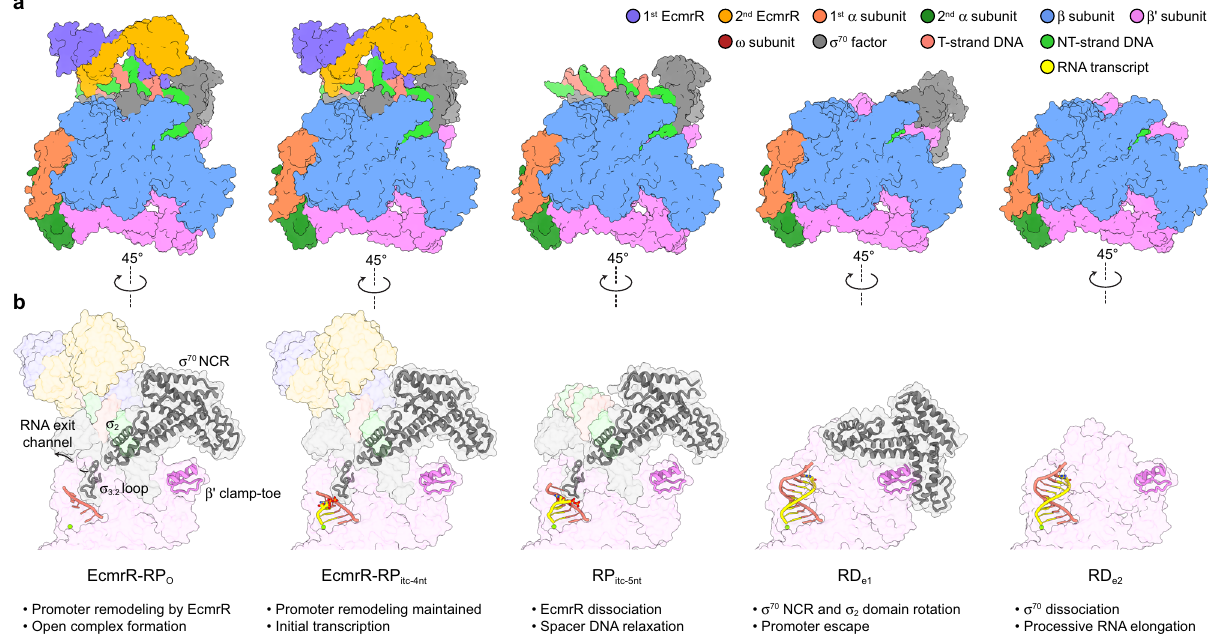
Fig. 7 Structural visualization of EcmrR-dependent transcription. a Side-by-side comparison of fi ve cryo-EM structures captured at different stages during EcmrR-dependent transcription. b σ 3.2 loop, σ 2 domain and NCR of σ 70 , β ' clamp-toe and RNA-DNA duplex are shown as cartoons, while other parts of the complexes are shown as transparent surfaces. For clarity, promoter DNA downstream of the – 10 element, RNAP α and β subunits are not